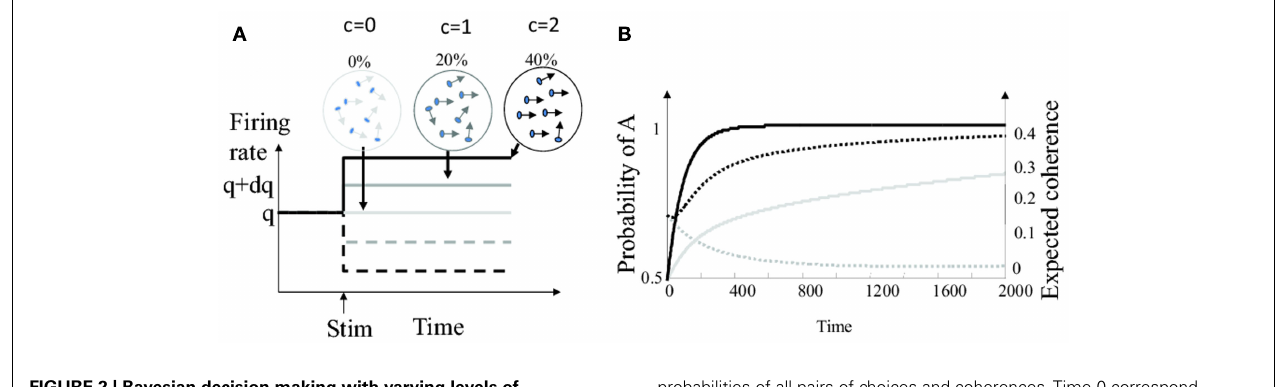
FIGURE 2 | Bayesian decision making with varying levels of motion coherence. (A) Firing rate of the model sensory neuron in response to motion stimuli (start of stimulation marked by upward pointing arrow) for different levels of coherence. Plain lines: stimulus is in the preferred direction. Dashed lines: stimulus is in the anti-preferred direction.The gray scale indicates the strength of motion coherence. (B) Outcome of the “full” Bayesian integrator computing the joint